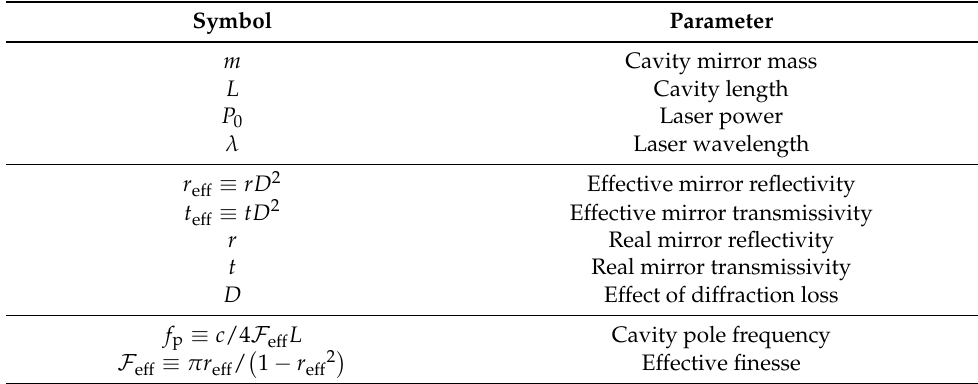
Figure 4. Pairs of the L shape interferometers. The E -mode is rotated by 45 ◦ from the A -mode, shown in Figure 3. Besides, every GW mode is generated by a linear combination: the plus-mode and the cross-mode. In other words, the pairs ( A , E (cid:48) ) and ( A (cid:48) , E ) are not correlated. Table 1. Definition of the DECIGO